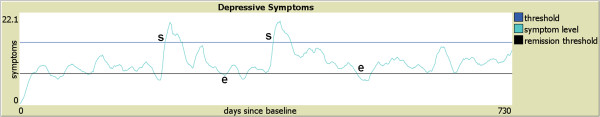
Typical output from model 2* (screen capture). * model parameters: diathesis = 1.4, stress_sd = 0.75, duration constant = 3, threshold = 15, remission stringency = 0.5. s = start of episode. e = end of episode.